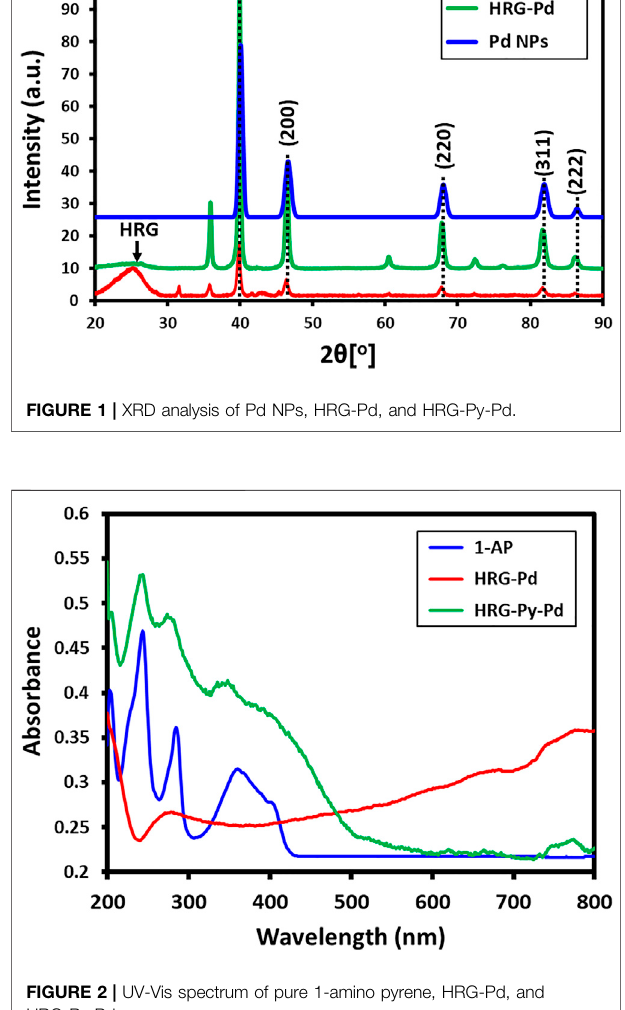
FIGURE 2 | UV-Vis spectrum of pure 1-amino pyrene, HRG-Pd, and HRG-Py-Pd.